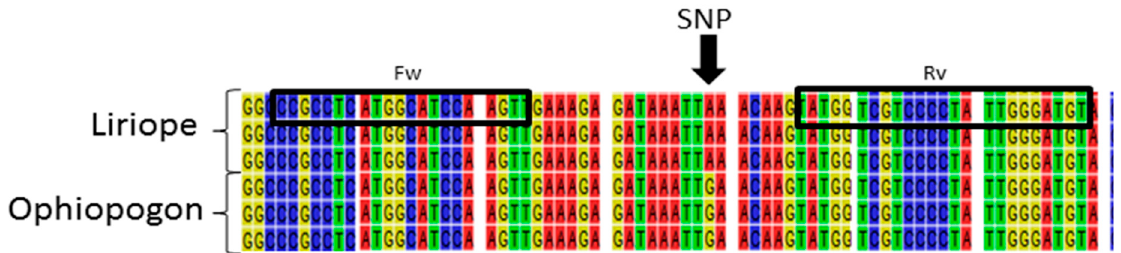
Figure 6. Schematic representation of the location of the HRM primers. The black arrow indicate the position of the SNP.